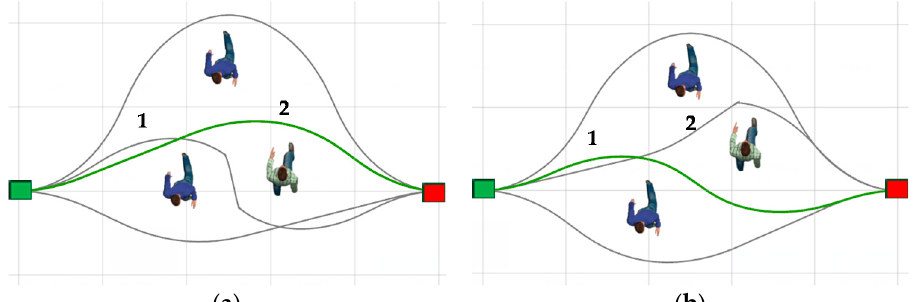
Figure 3. The movements of pedestrians cause the optimal local trajectories of the relevant topology to change: ( a ) The optimal local trajectories before the movements; ( b ) the optimal local trajectories after the movements, boxes in green and red are the robot’s initial position and goal position, respectively; the trajectories in green and grey are globally optimal trajectories and candidate local trajectories, respectively.